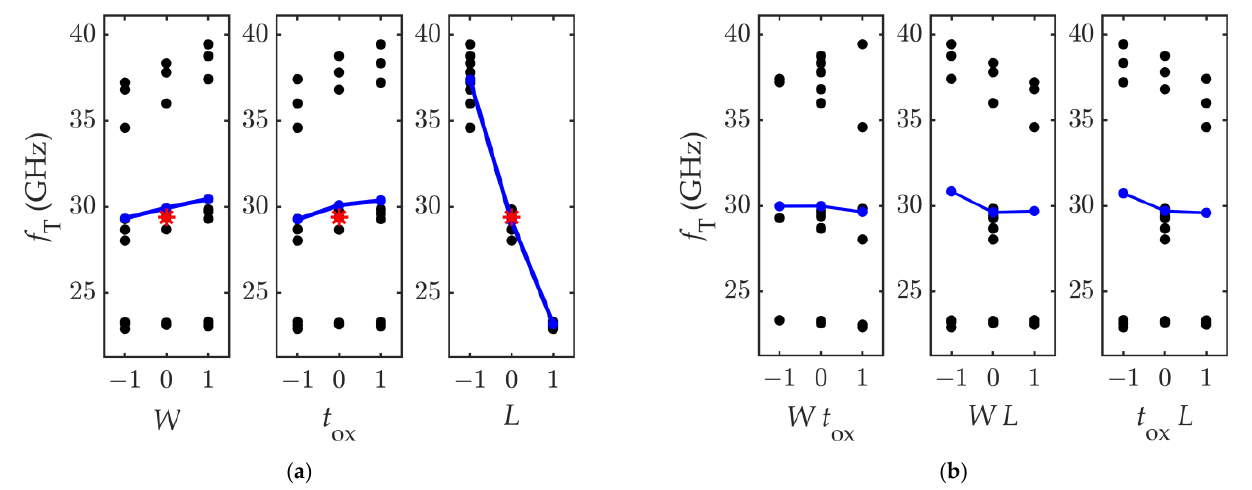
Figure 5. Computed values of f T against ( a ) the input factors and ( b ) the factor-mixed products. The blue lines connect the f T average values, and the red star marks the response computed at the nominal set of the input parameters. Table 4. f T main effects and interaction